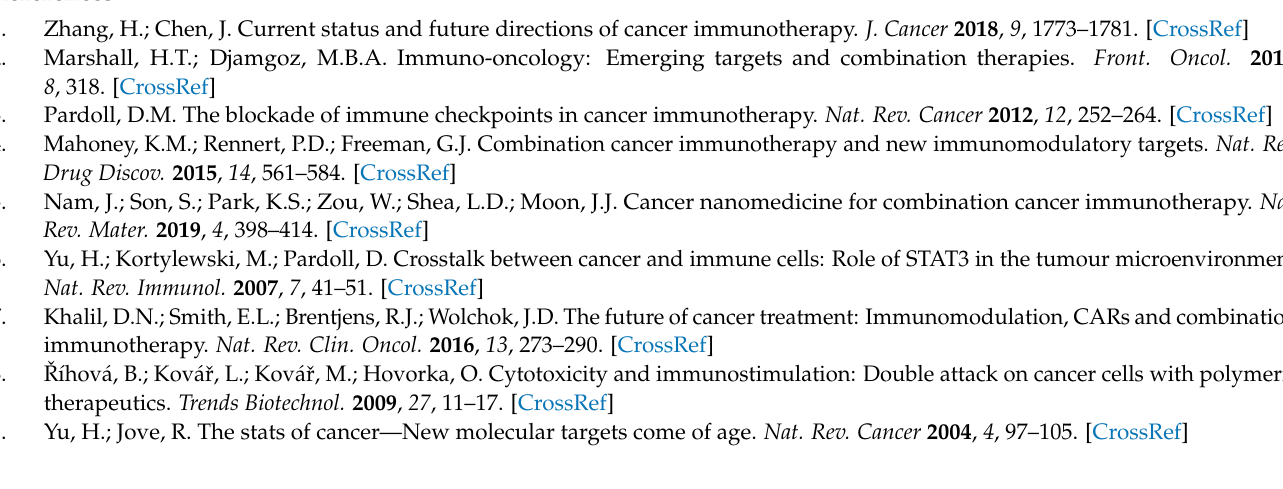
Figure S5: Representative chromatograms after 8 h of CuD release, Figure S6: Systemic toxicity and survival of mice treated with free CuD or LP-CuD, Figure S7: Systemic toxicity of the combination treatment with MP-Dox and